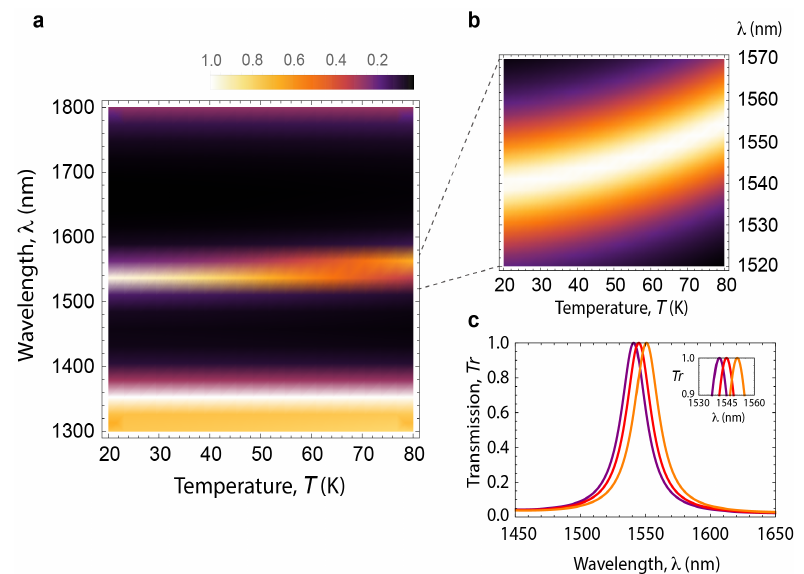
Figure 4. ( a ) Simulated photonic band structure of the ( BTO/Y 2 O 3 ) 5 /YBCO/ ( Y 2 O 3 /BTO ) 5 filter ( N = 5) as a function of wavelength and temperature T , in the region T = 20 K to 80 K, with d s = 30 nm, at normal incidence. The dark areas correspond to the high-reflectance ranges, and yellow regions indicate high transmission bands where radiation passes through the structure. ( b ) Optical response amplification of the N = 5 PhC filter to a wavelength range between 1520 nm and 1570 nm. ( c ) Transmission light behavior of the N = 5 filter as a function of temperature for T = 30 K (purple line), T = 50 K (red line) and T = 70 K (orange line),